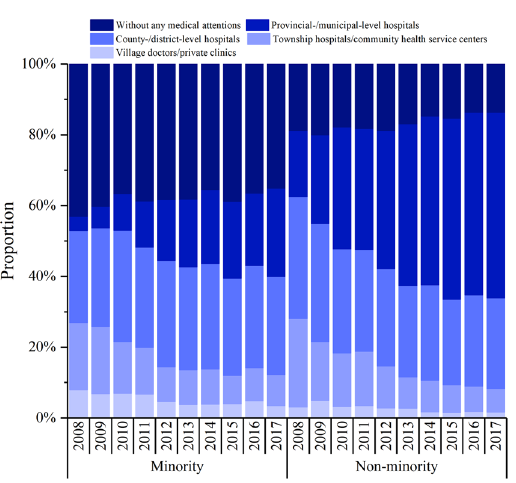
Figure 6. Health care services for children under-five in Sichuan Province of